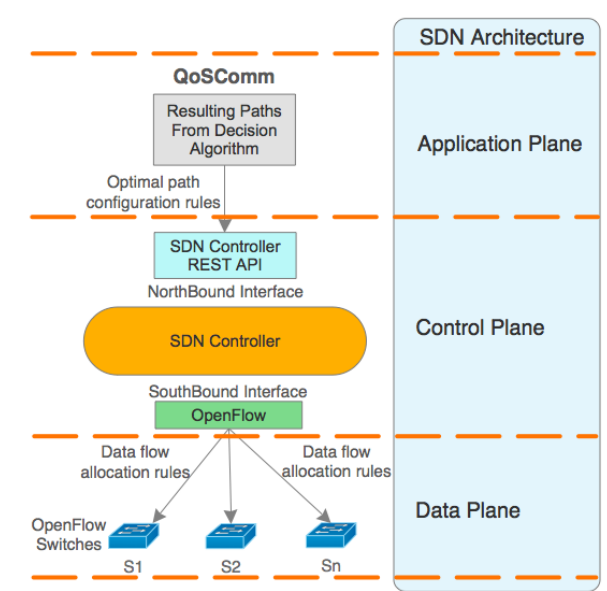
Figure 3. QoSComm communication process and its reference in the SDN architecture.